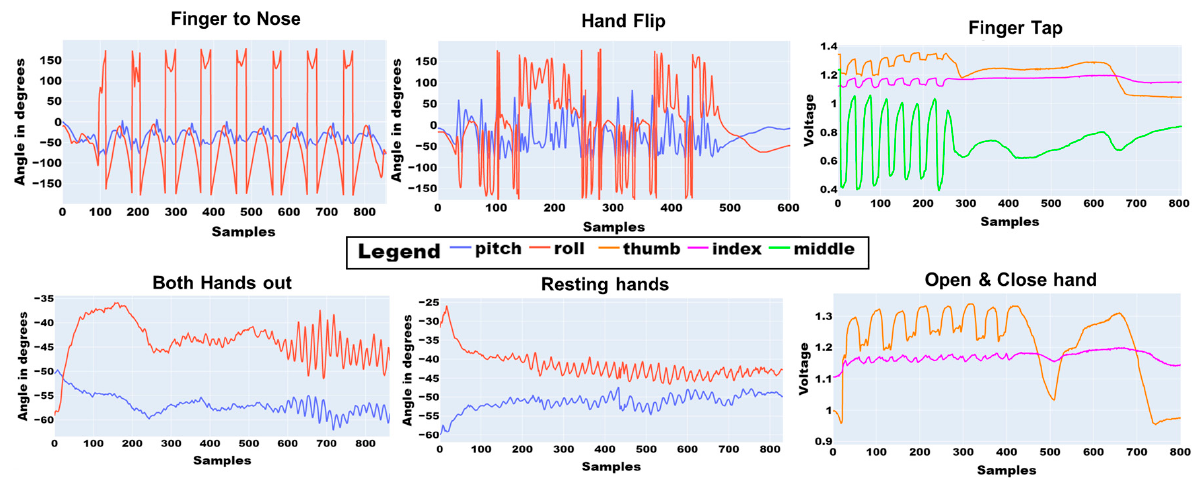
Figure 6. Inertial, flexion signals obtained for the various movement tasks.